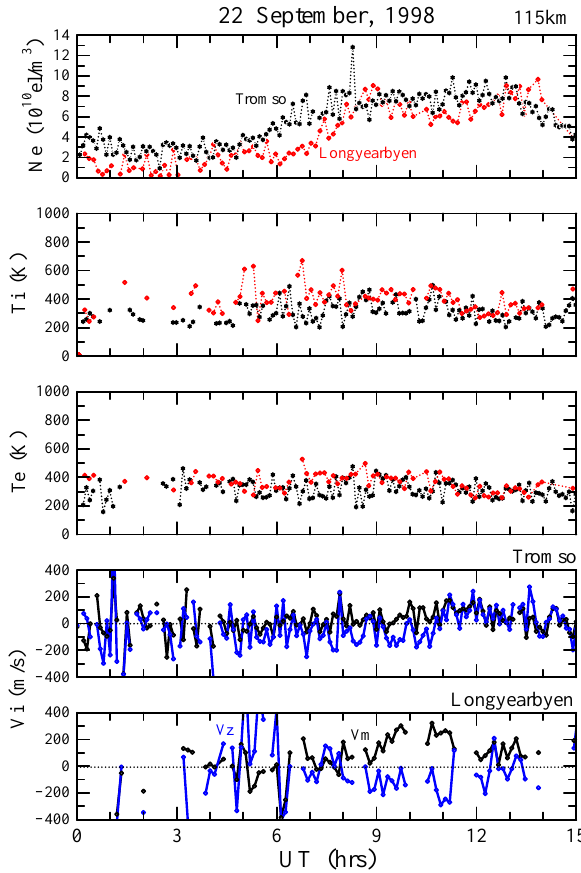
Fig. 4. Summary plots of the ionospheric parameters at 115km altitude measured by the Tromsø radar and by the Svalbard radar from 00:00 to 15:00UT on 22 September 1998. The top panel shows the electron density obtained from the field-aligned beam at Tromsø (black) and Longyearbyen (red). The ion and electron tem- peratures obtained from the field-aligned beam at Tromsø (black) and Longyearbyen (red) are shown in the second and third panels, respectively. The derived ion velocities at Tromsø and Longyear- byen are plotted in the fourth and fifth panels, respectively. The meridional component ( V m ) is shown by the black line, and the zonal component ( V z ) the blue line. The positive values indicate the northward and eastward